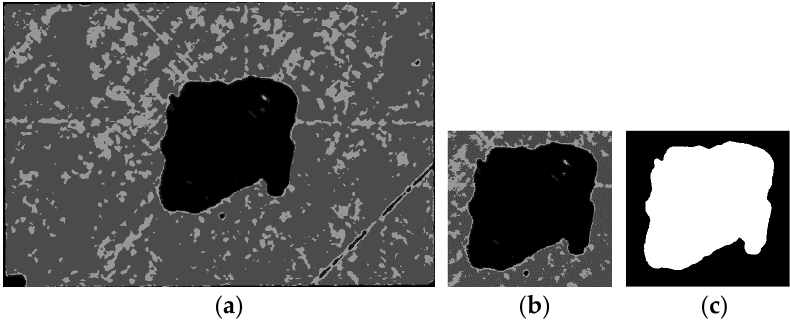
Figure 29. Delamination defect detected by UT and its extraction: ( a ) Delamination defect detected by UT; ( b ) ROI; ( c ) Defect segmentation.